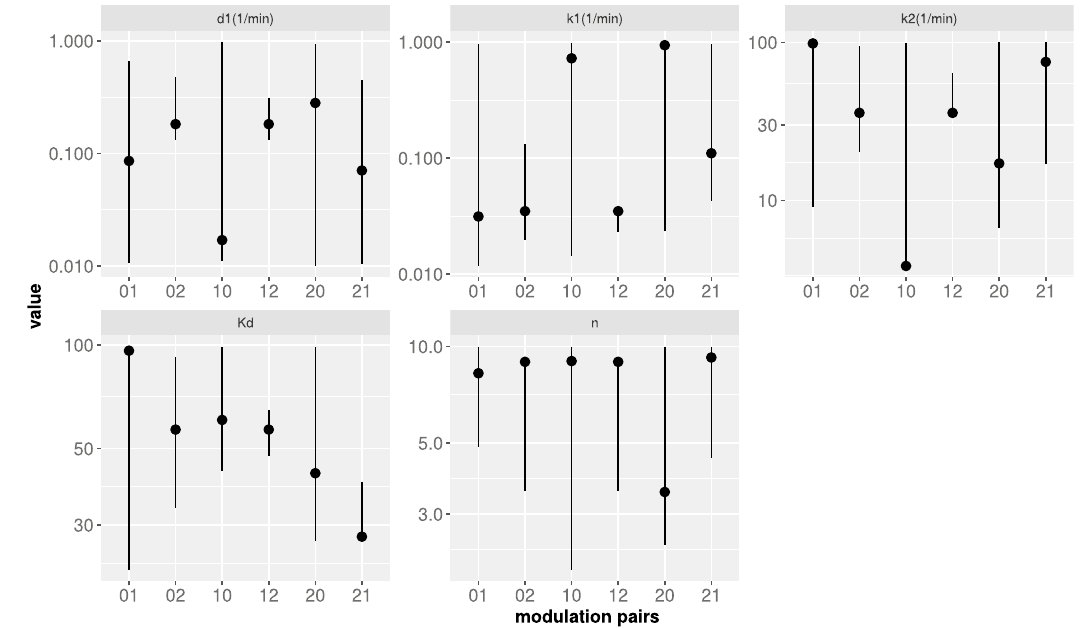
Figure 5. Projection on each parameter axis of the Minmax regions obtained for each pair of modulation input types and the T c output time cut. The pairs of digits in the horizontal axes identify the modes for which the information transmission has been maximized (first digit) and subsequently minimized (second digit) to determine the Minmax regions, with 0: duration, 1: amplitude and 2: frequency. The symbols correspond to the values that minimize MI for the second digit modulation given that MI stays within 90% of MI M for the first digit